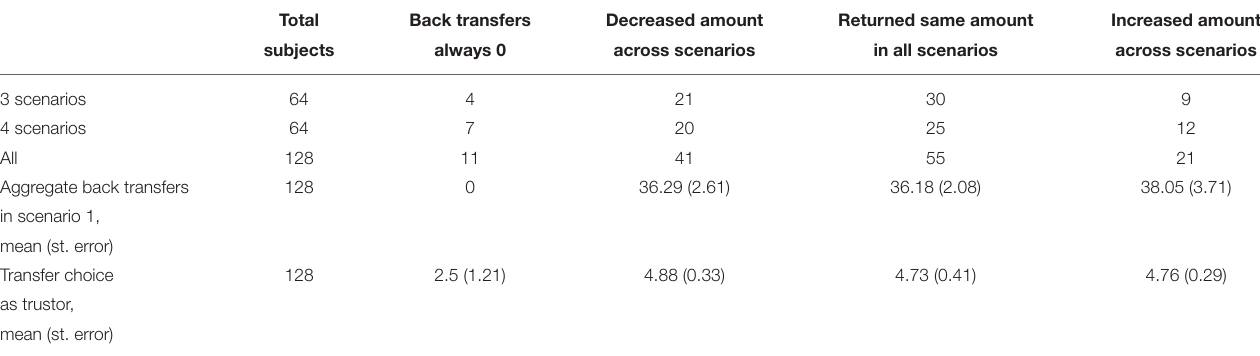
TABLE 4 | Categorization based on the back transfer schedules across scenarios. Total Back transfers Decreased amount Returned same amount Increased amount subjects always 0 across scenarios in all scenarios across